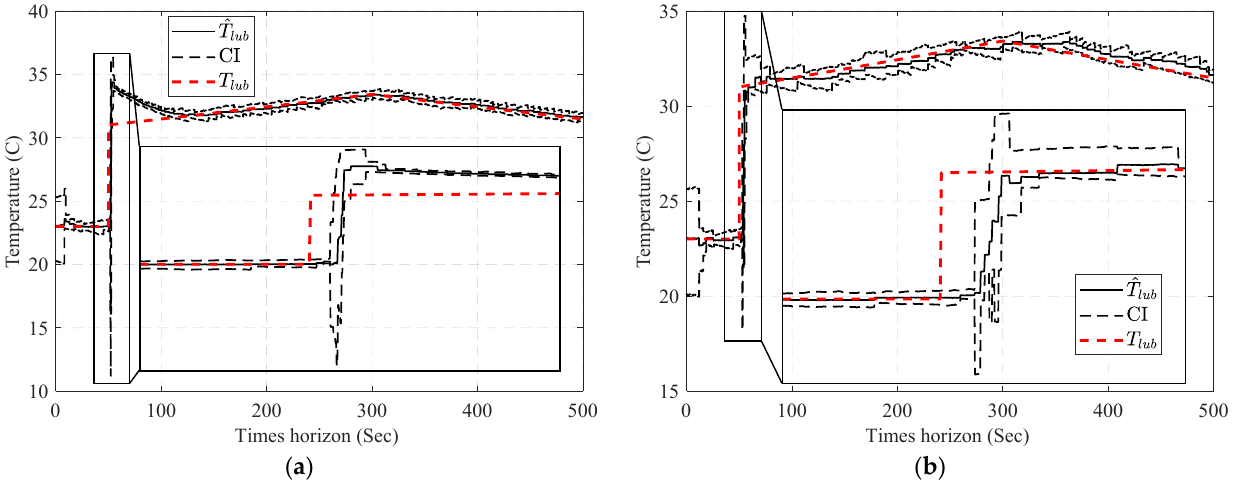
Figure 11. Result of the estimated 𝑇 (cid:3039)(cid:3048)(cid:3029) , using APF: ( a ) low noise scenario and ( b ) high noise scenario.